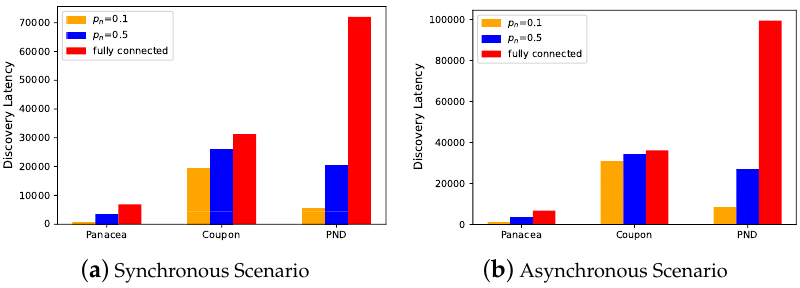
Figure 2. The neighbor discovery algorithms work better in partially connected networks and Panacea -WCD outperforms the other